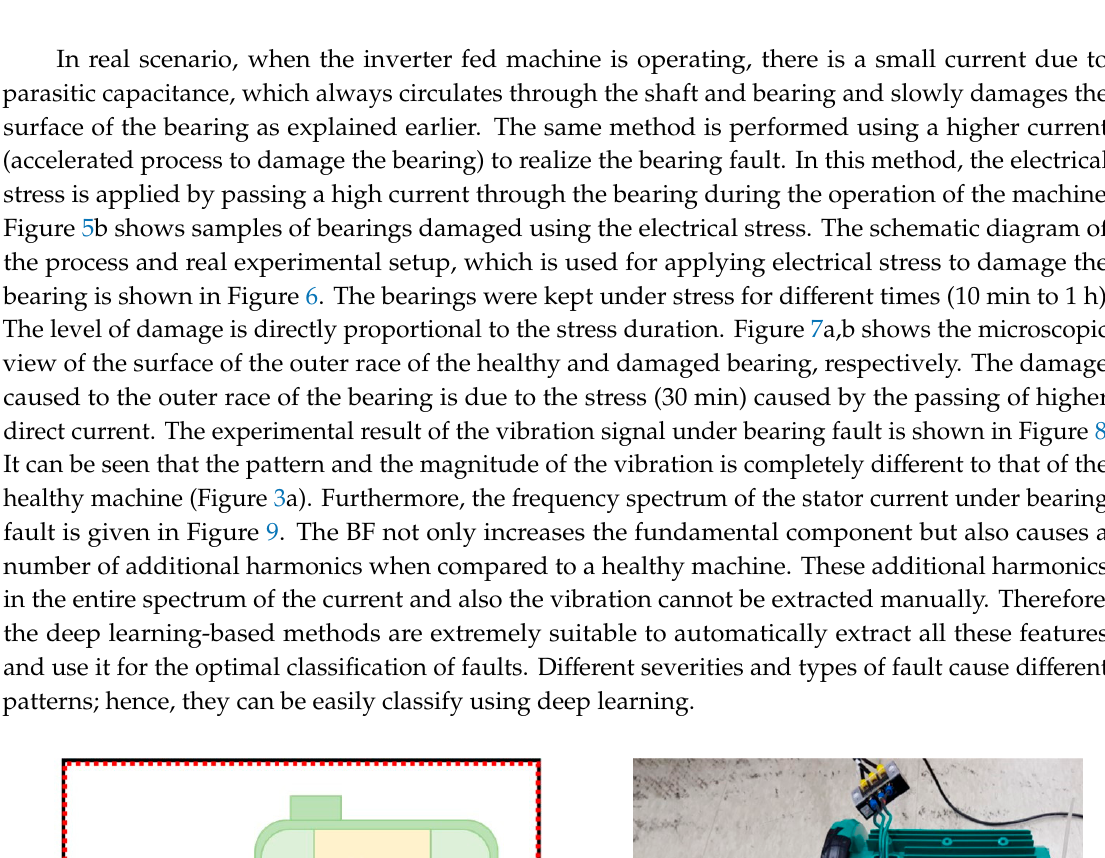
Figure 5. ( a ) Structure of the bearing used in benchmark PMSM; ( b ) Damaged bearing samples.